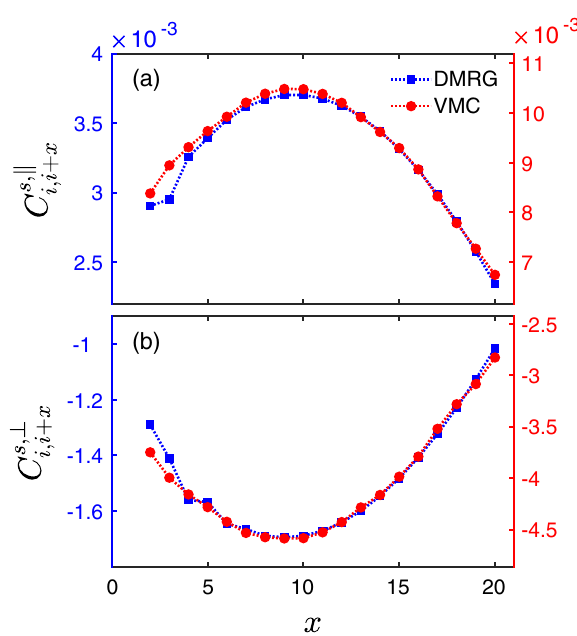
as a function of the side length pair , versus n with an t; pair